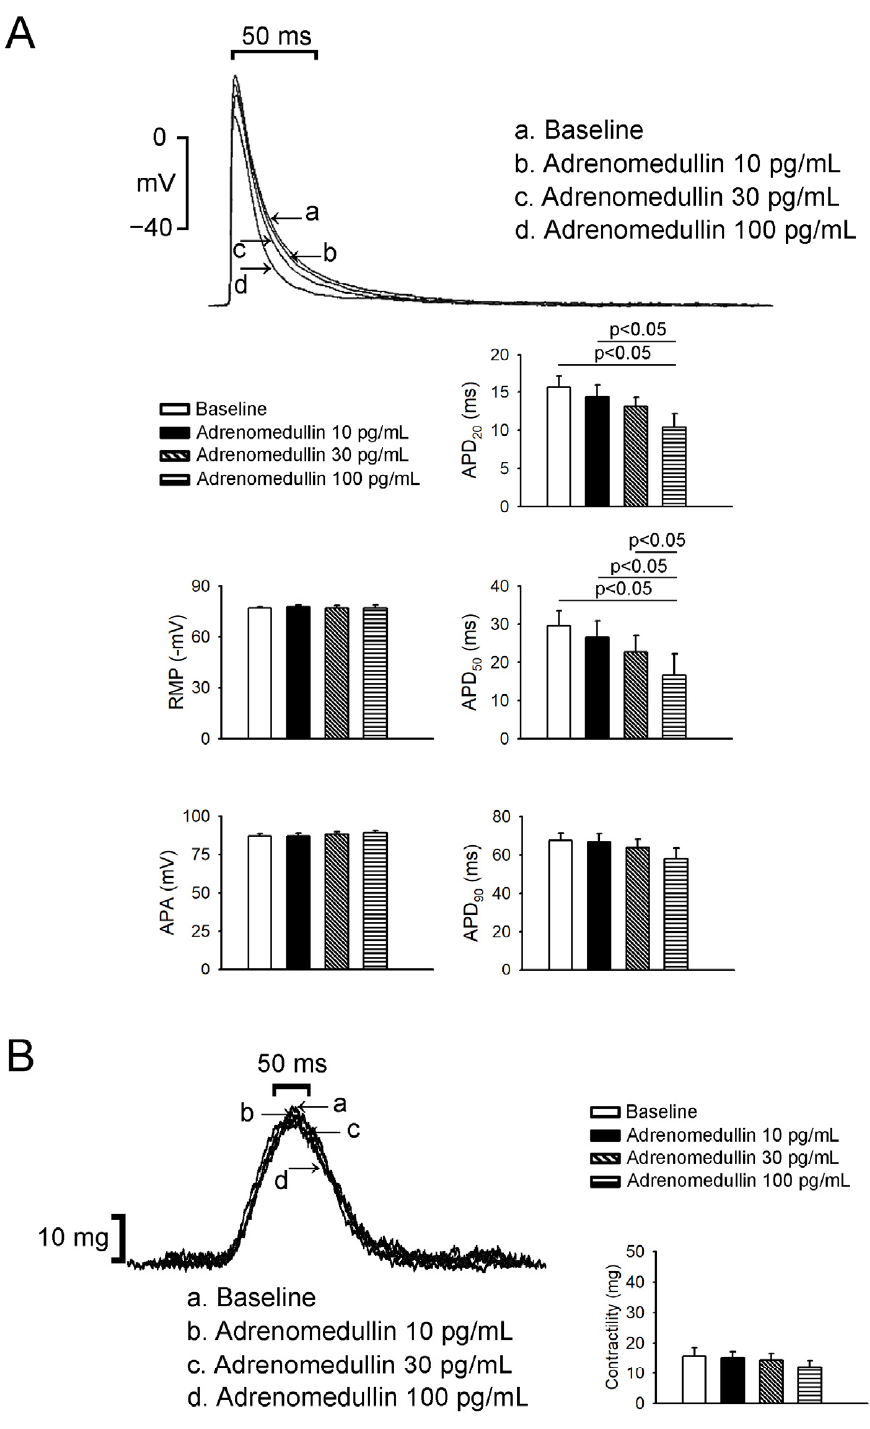
Figure 5. Effects of adrenomedullin on right atrium (RA) AP morphology and contractility. ( A ) The superimposed traces illustrate the effects of adrenomedullin on RA APs. Adrenomedullin